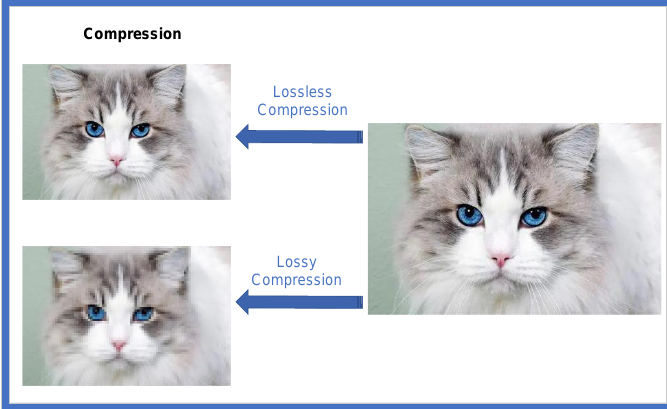
Figure 3. Cloud virtual desktop image compression